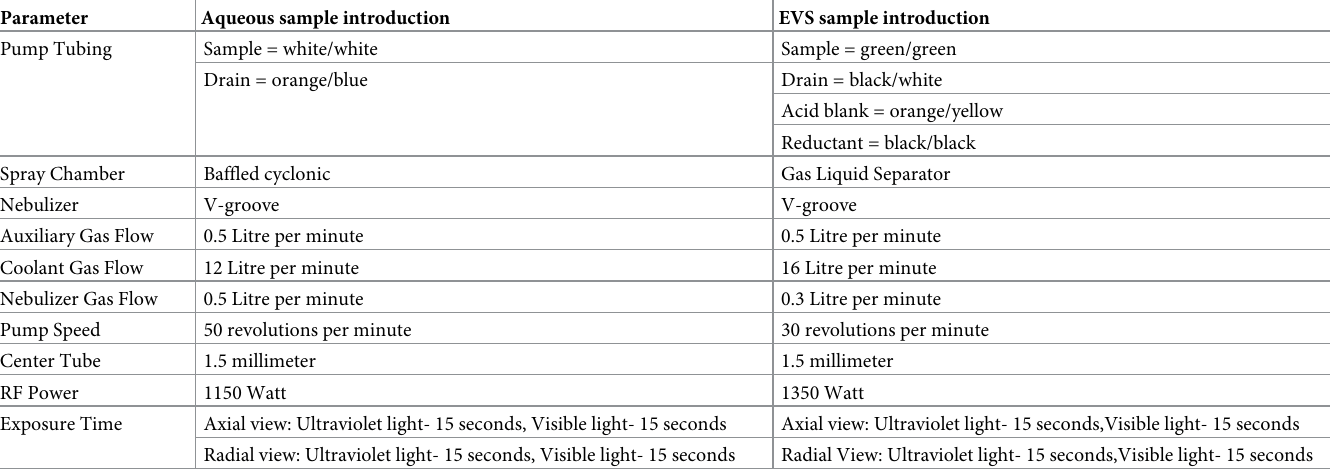
Table 1. The ICP OES instrument parameters that will be used during analysis of Pb, Al, and Hg in the groundwater and/or blood